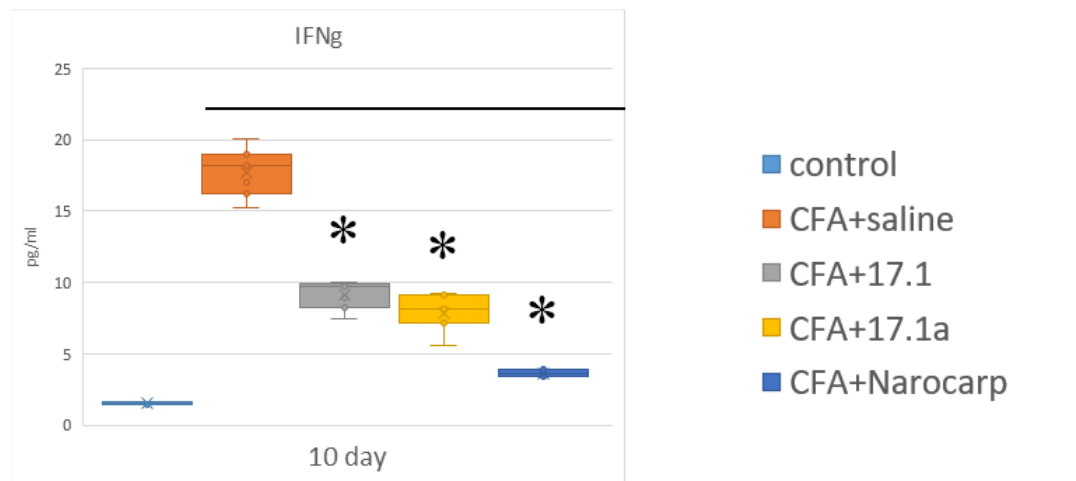
Figure 5. Changes of the level of cytokines in the effector phase of immune response (IFN- γ ) in the plasma of mice after CFA-induced arthritis. (Control—control animals without CFA injection, CFA—animals with induced via CFA arthritis, +saline—animals were treated by phosphate buffered saline (PBS), +17.1a, +17.1, +Norocarp—animals were treated by a specified agent, n = 7 for each group). ( p -value: * < 0.05).